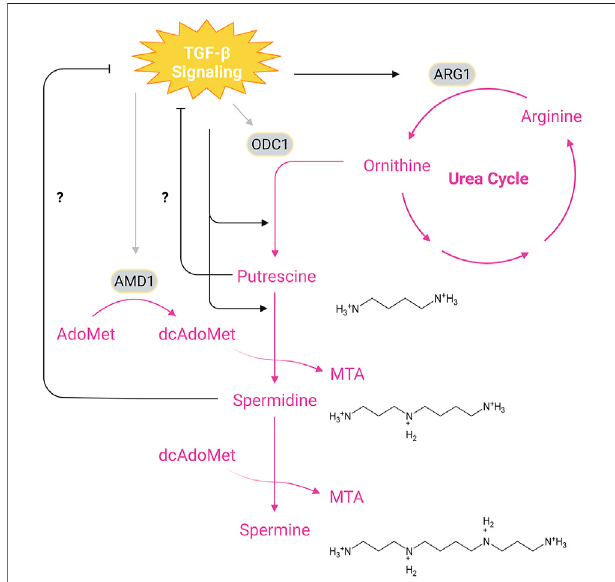
FIGURE 4 | Interplay Between TGF- β Signaling and Polyamine Synthesis. The main biosynthetic pathway of polyamines begins with ODC1- catalyzed formation of putrescine from ornithine, a product of the urea cycle, whichisgenerated from argininethroughhydrolysis byARG1.Synthesis of spermidine and spermine requires transfer of aminopropyl groups from dcAdoMet, a decarboxylated product of AdoMet (S-adenosylmethionine) catalyzed by AMD1. Putrescine and spermidine may inhibit TGF- β signaling since depletion of cellular putrescine and spermidine has been shown to enhance T β RI/II levels and Smad nuclear translocation, while TGF- β signaling promotes synthesis of putrescine and spermidine through upregulation of ARG1. In addition, TGF- β signals can stimulate or dampen the activity of ODC1andAMD1dependingonthecelltypes.Pinktextsandarrows,theurea cycle and polyamine synthesis. Abbreviations: MTA, methylthioadenosine; ARG1, arginase 1; ODC1, ornithine decarboxylase 1; AMD1, adenosylmethionine decarboxylase 1. Figure is created with